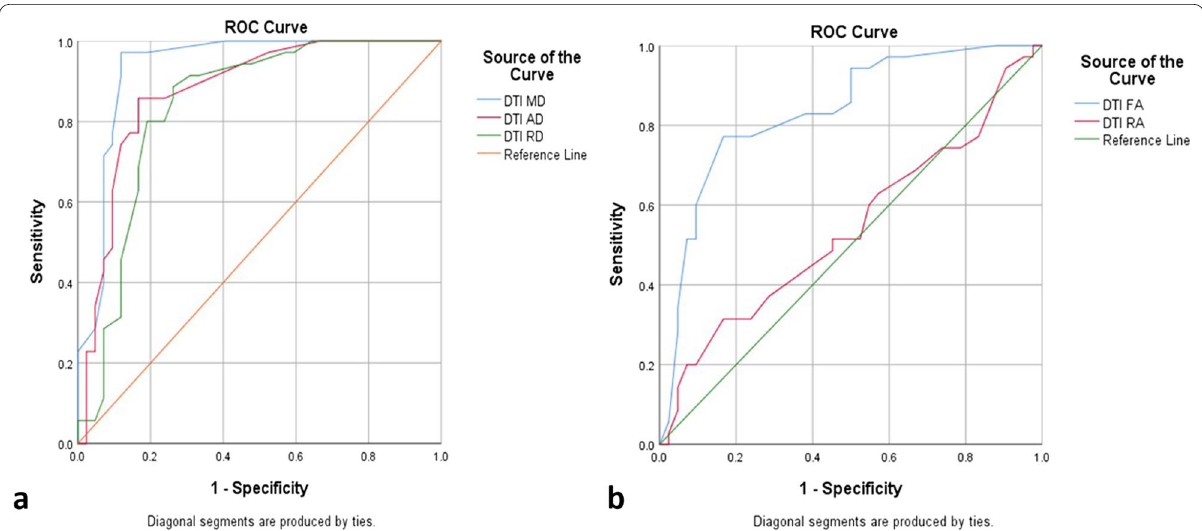
Fig. 3 ROC curves showed that MD had the highest sensitivity, specificity, and AUC when compared to AD and RD ( a ) and FA showed higher sensitivity, specificity, and AUC than RA ( b